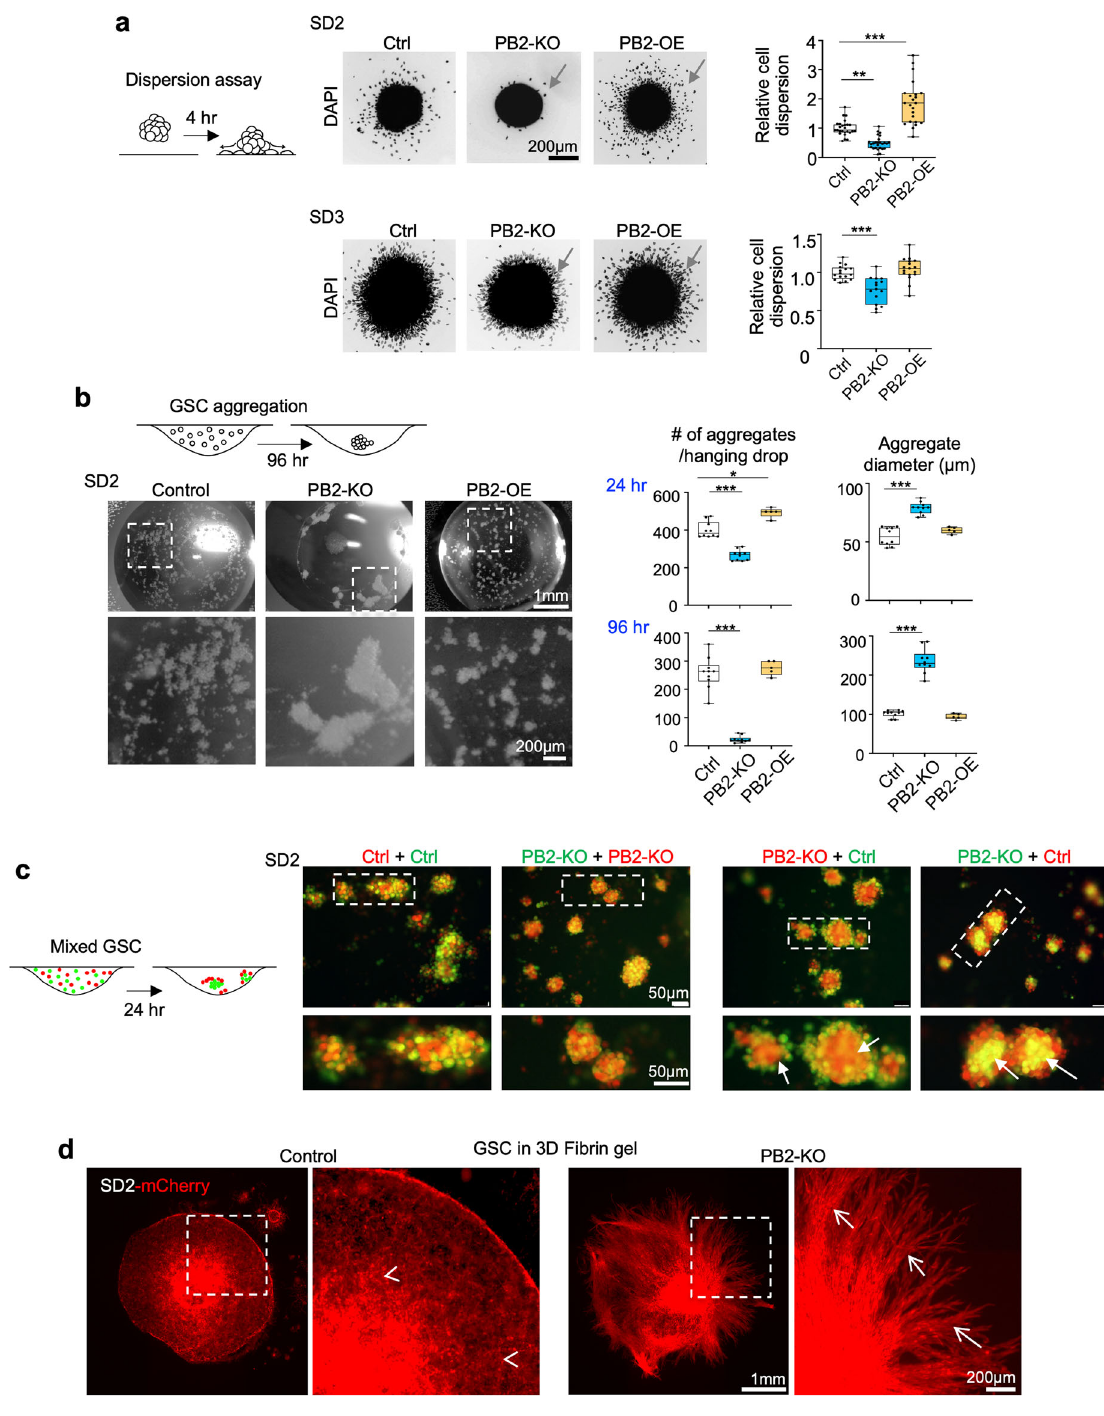
responses to the biomechanical changes upon Plexin-B2